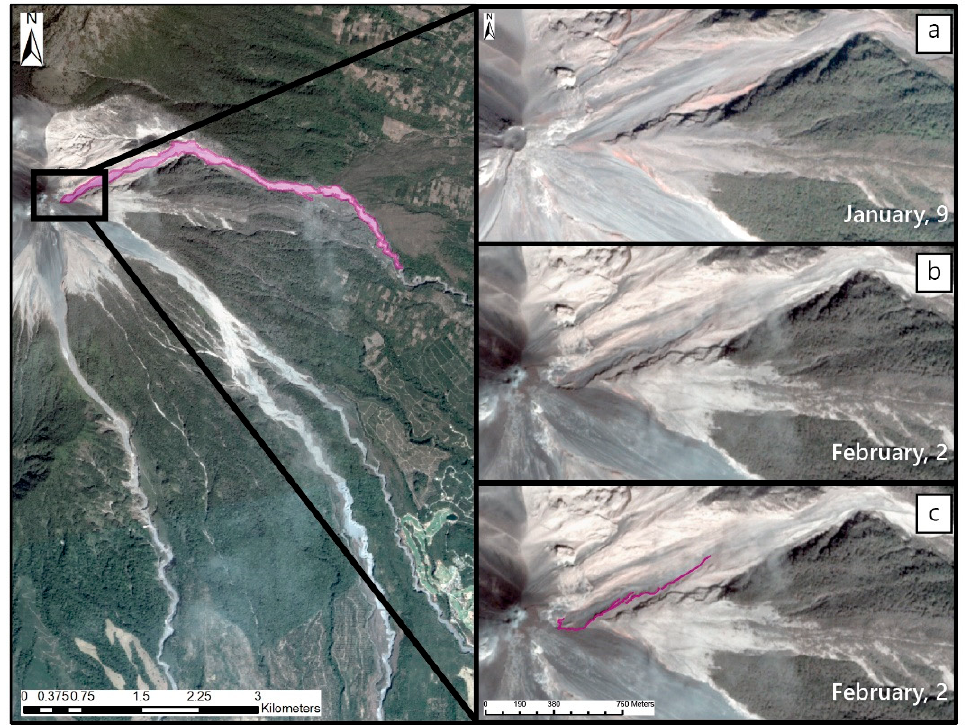
Figure 7. PlanetScope images of Fuego collected on January 9, 2018 at 16:57 UTC and February 2, 2018 at 15:57 UTC, showing morphological changes pre- ( a ) and post-eruption ( b ). The February 2 PlanetScope image ( c ) shows the presence of a scar formed during the February 2018 paroxysm, in the upper reaches of Barranca Honda.